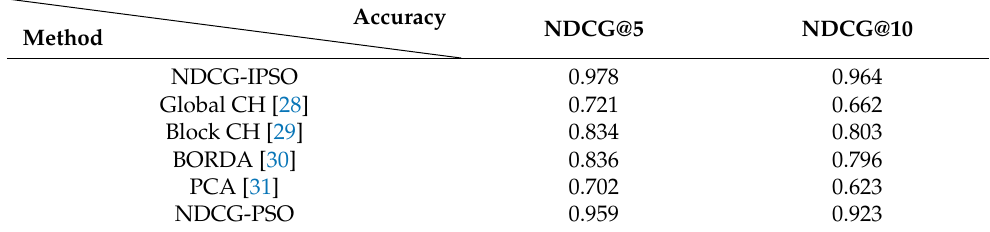
Table 3. Comparative analysis of image search results based on different